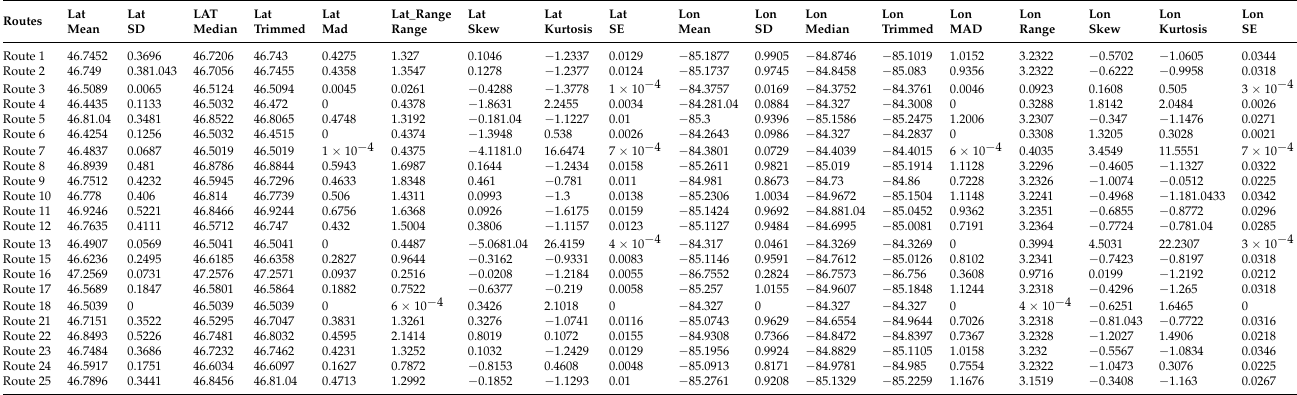
Table 1. All statistic values are computed for latitude and longitude, and Route 25 is our route-target. Routes